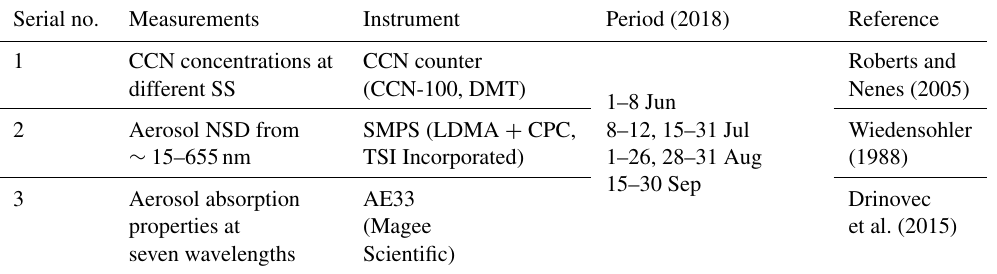
Table 1. Details of aerosol measurements used in the current study. Serial